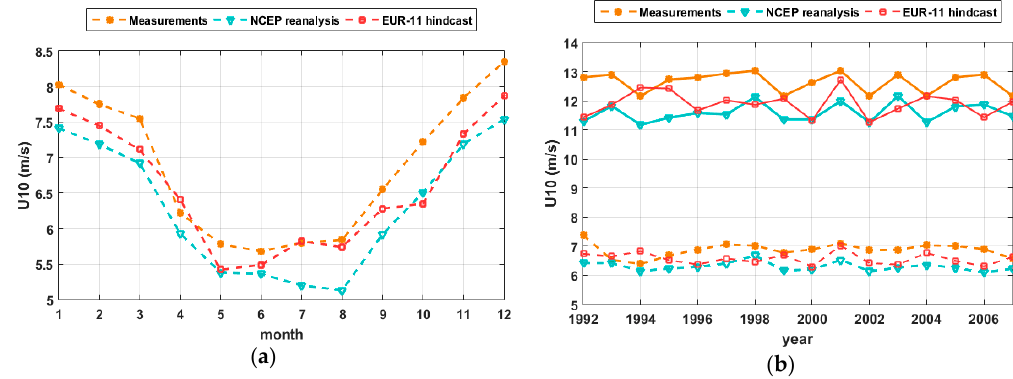
Figure 4. Comparison between U10 measured at Gloria platform and the simulated values from NCEP reanalysis and EUR-11 hindcast at the same location, time interval 1992–2007: ( a ) Monthly means; and, ( b ) Annual means (dashed lines) and 95th percentile (solid lines).